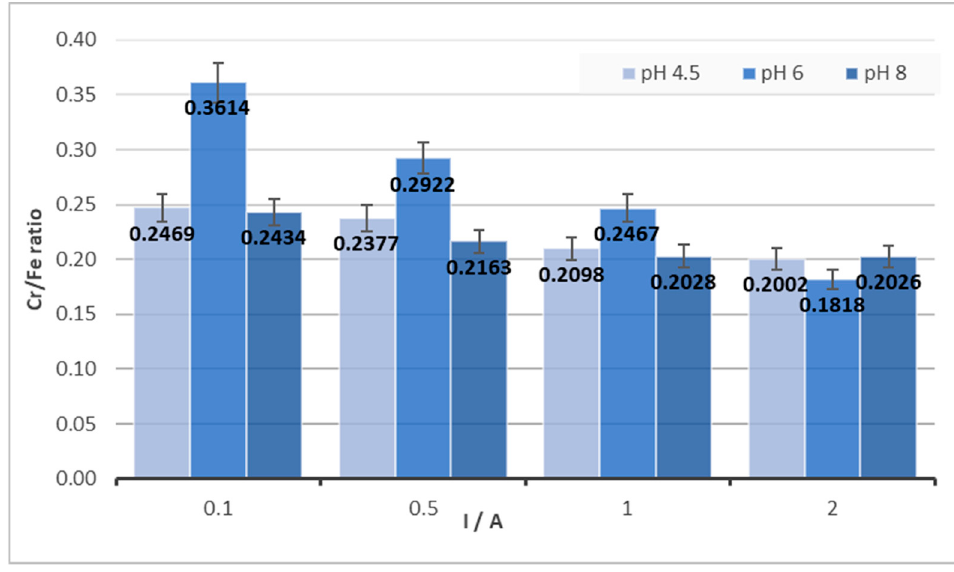
Figure 5. The Cr/Fe ratio’s dependence on pH for c(Cr(VI)) = 1000 mg/L and c(NaCl) = 3000 mg/L for di ff erent amperages.